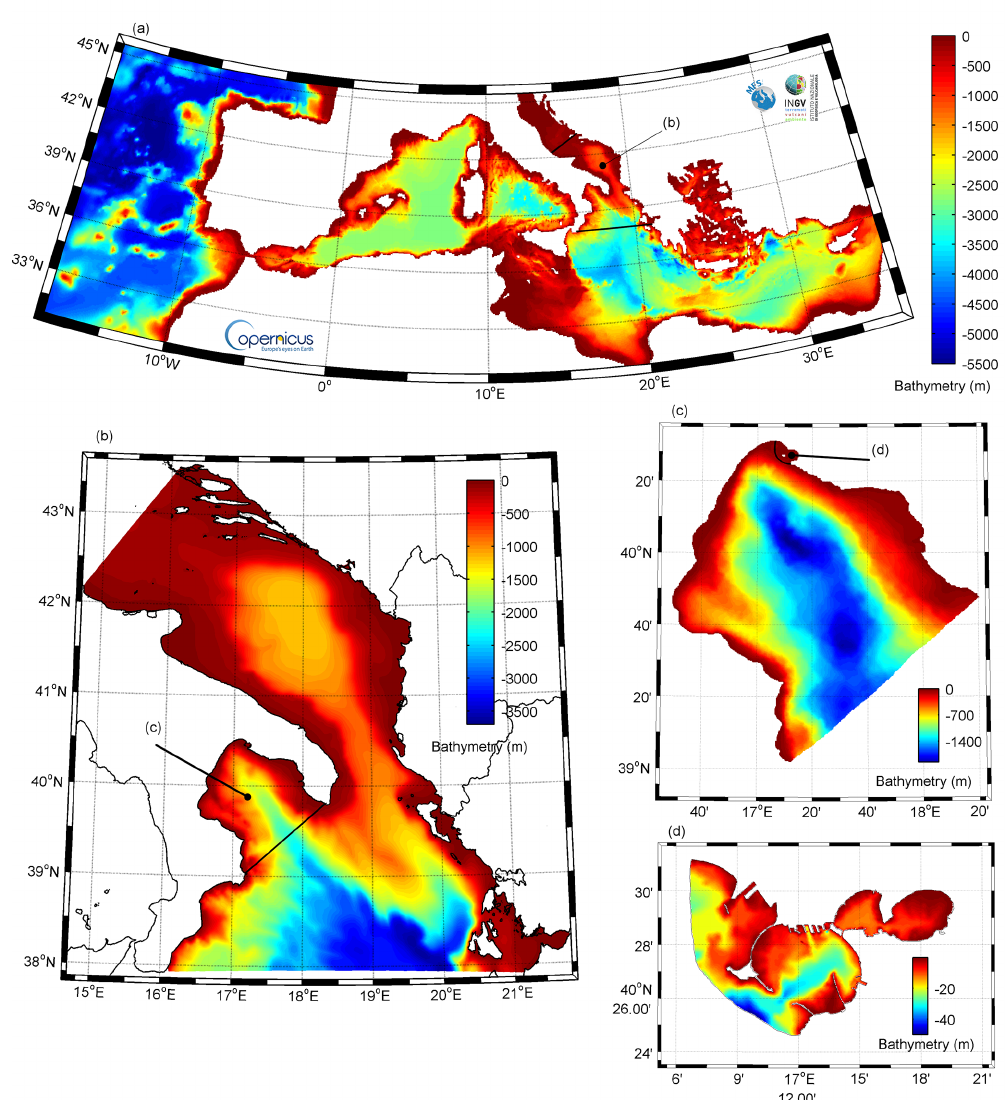
Figure 1. Multiple-nesting approach from the Mediterranean Sea scale with (a) MFS and (b) SANIFS to a coastal-engineering-scale model performed with the TELEMAC suite (c) in 2-D for the Gulf of Taranto and (d) in 3-D for the Taranto Sea: maps show the adopted